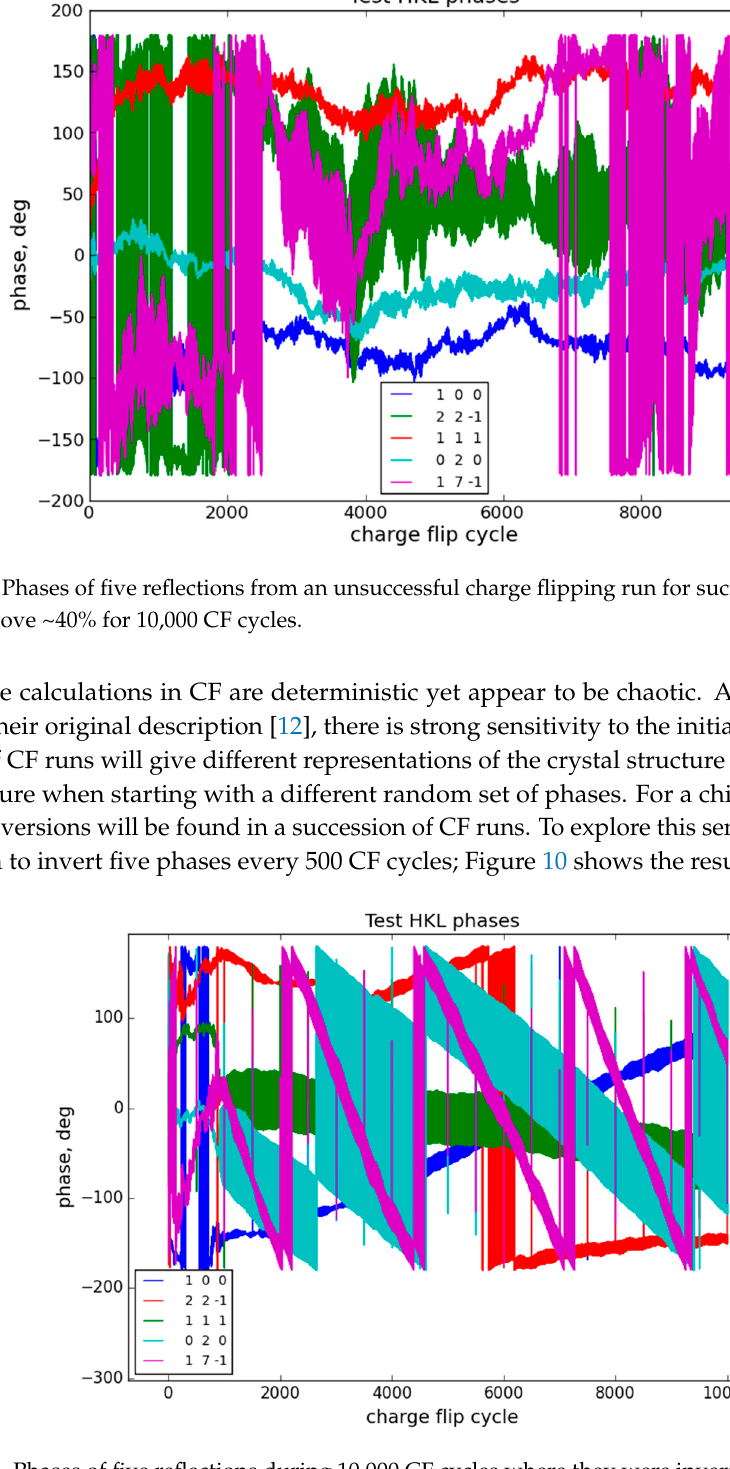
Figure 10. Phases of five reflections during 10,000 CF cycles where they were inverted at every 500th CF cycle (vertical lines).